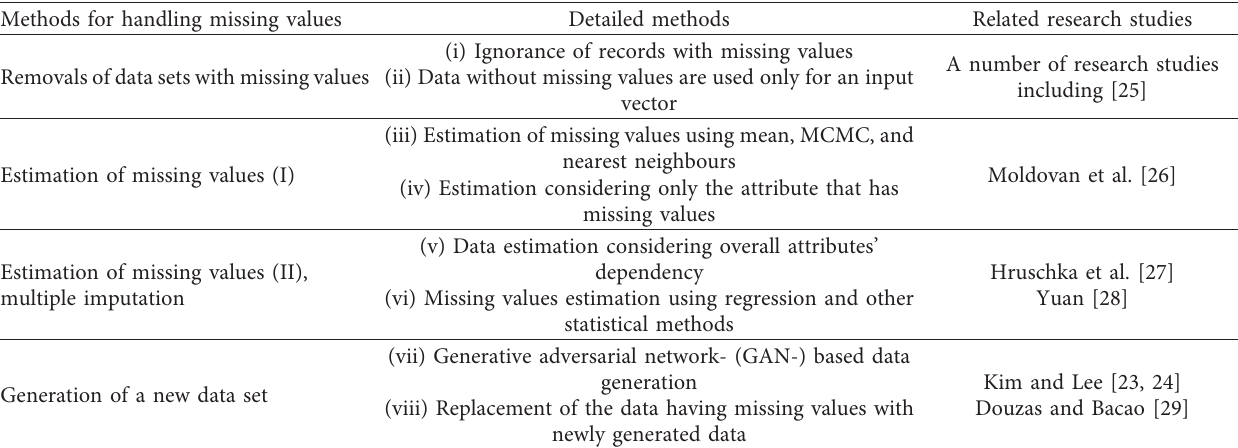
Table 4: Various methods for handling missing